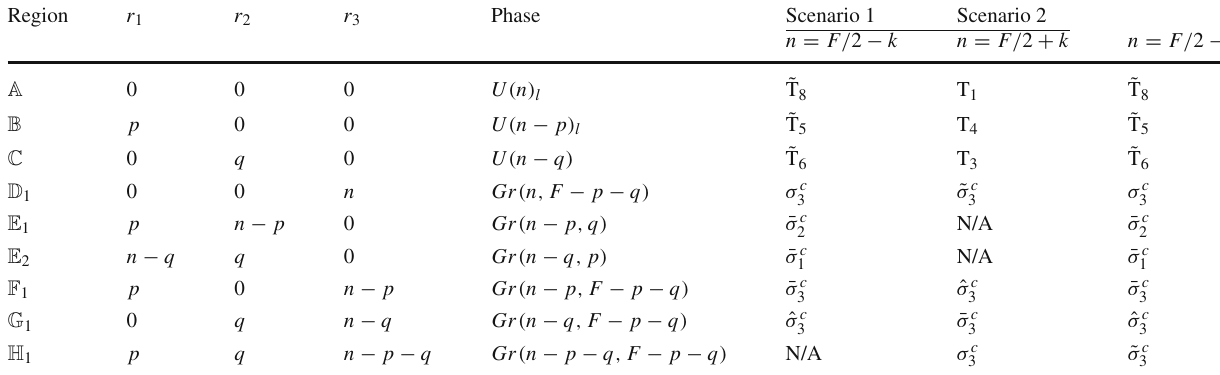
Table 3 Phases of the bosonic theory with q ≤ p ≤ n < F − p − q ≤